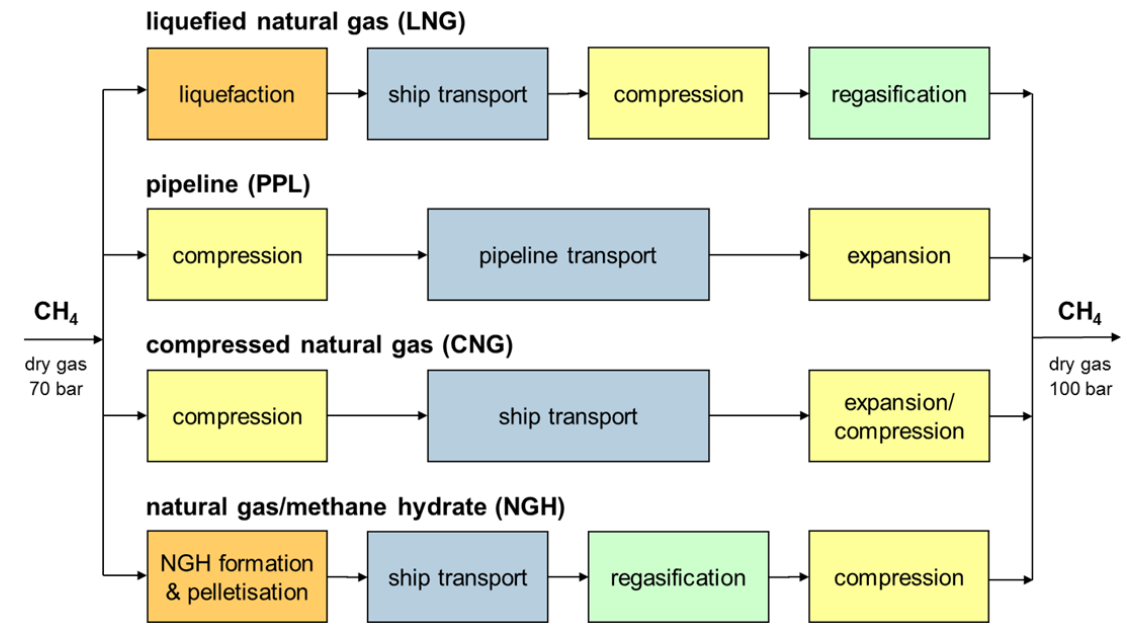
Figure 8. Technologies and system boundaries for a comparative assessment of natural gas transport options